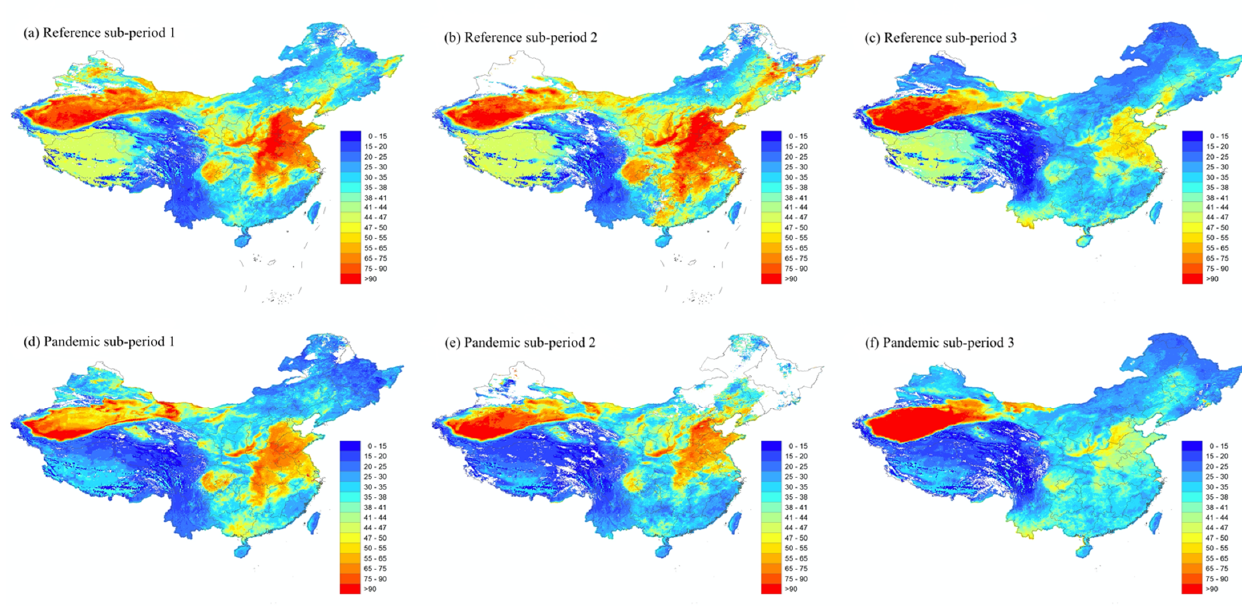
Figure 4. ( a ) Average PM 2.5 distribution in the reference sub-period 1; ( b ) Average PM 2.5 distribution in the reference sub-period 2; ( c ) Average PM 2.5 distribution in the reference sub-period 3; ( d ) Average PM 2.5 distribution in the pandemic sub-period 1; ( e ) Average PM 2.5 distribution in the pandemic sub-period 2; ( f ) Average PM 2.5 distribution in the pandemic sub-period 3. ArcGIS was used (version 10.7.1). Table 1. Summary statistics of PM 2.5 predictions by cluster during modeling periods ( µ g/m 3